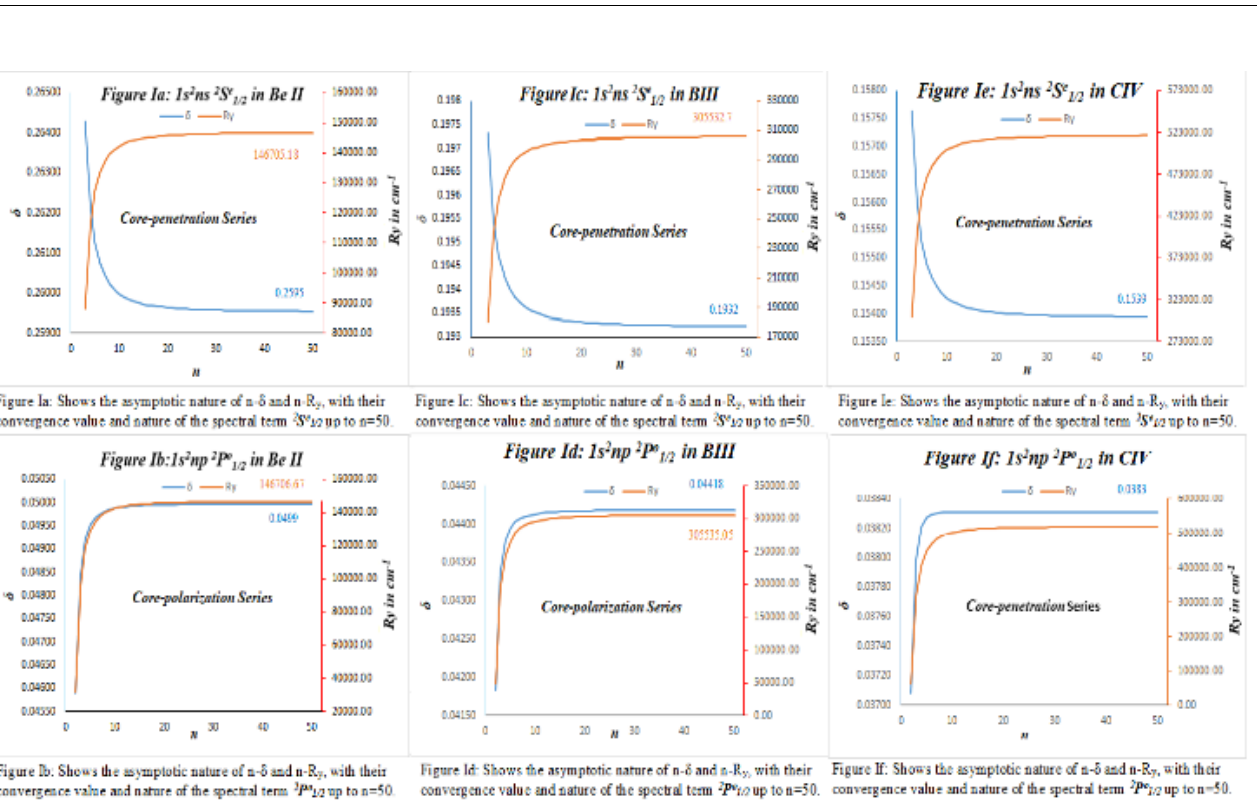
Fig. 1. n - δ and n-Ry curves in comparisons for Z = 4-6, up to n = 50 for 1 s 2 ns 2 S e 1/2 and 1 s 2 np 2 P o 1/2 . Showing the core penetration nature for all 1 s 2 ns 2 S e 1/2 and the core polarization in 1 s 2 np 2 P o 1/2 for Z = 4 and 5, but an exception is occurred at Z = 6, that is